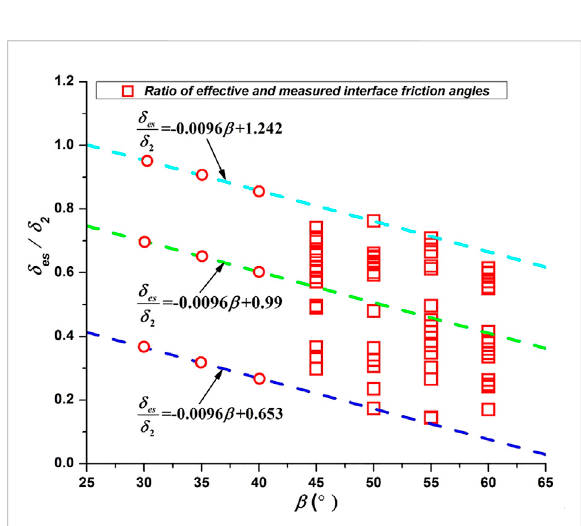
FIGURE 5 Relation of reduction rate of interface friction angle ( δ es / δ 2 ) and inclination angle ( β ); the red circle is where the value of δ es will be calculated for fl ume